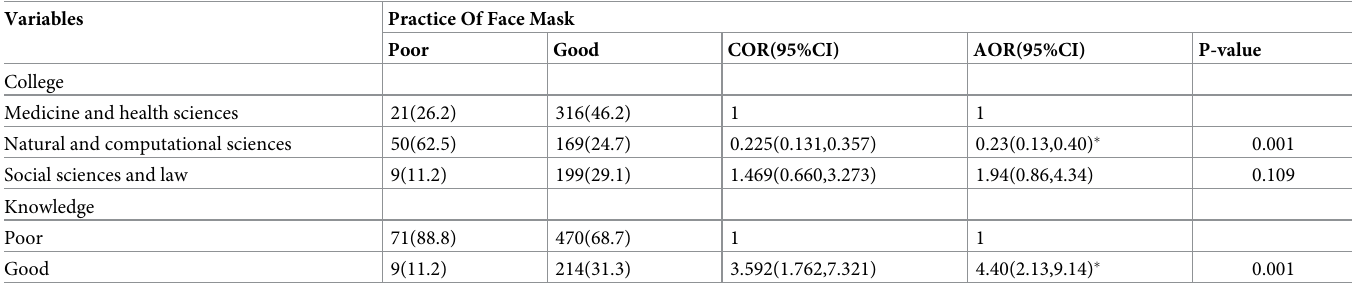
Table 7. Factors affecting practice of the respondents on knowledge, attitudes, and practices of face mask utilization and associated factors in COVID-19 pandemic among Wachemo university students, southern Ethiopia: February to March 2021 (n = 764).